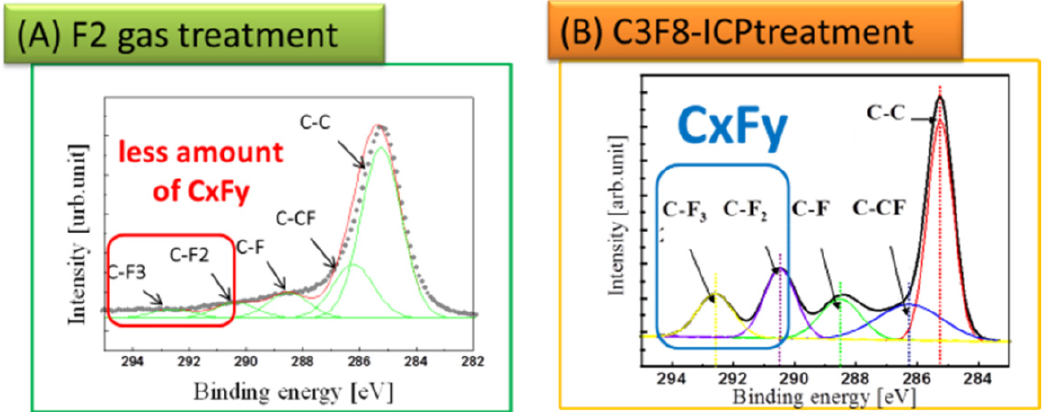
Figure 3. X-ray photoelectron spectra of the C–F diamond surfaces: ( A ) a narrow scan of C 1s